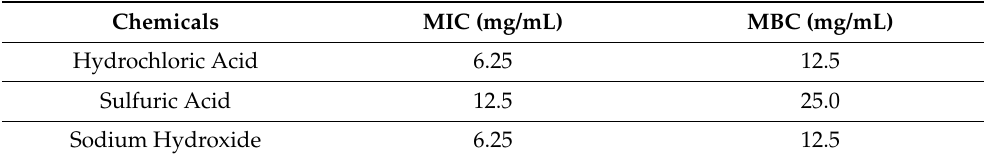
Table 1. Minimum inhibitory concentrations (MICs) and minimum bactericidal concentrations (MBC) of chemicals treated in L. monocytogenes culture.